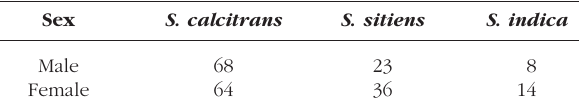
Table II. – Number of males and females flies observed during the survey period (July 2004 to June 2005) at Kamphaengsaen Campus, Nakornpathom province,